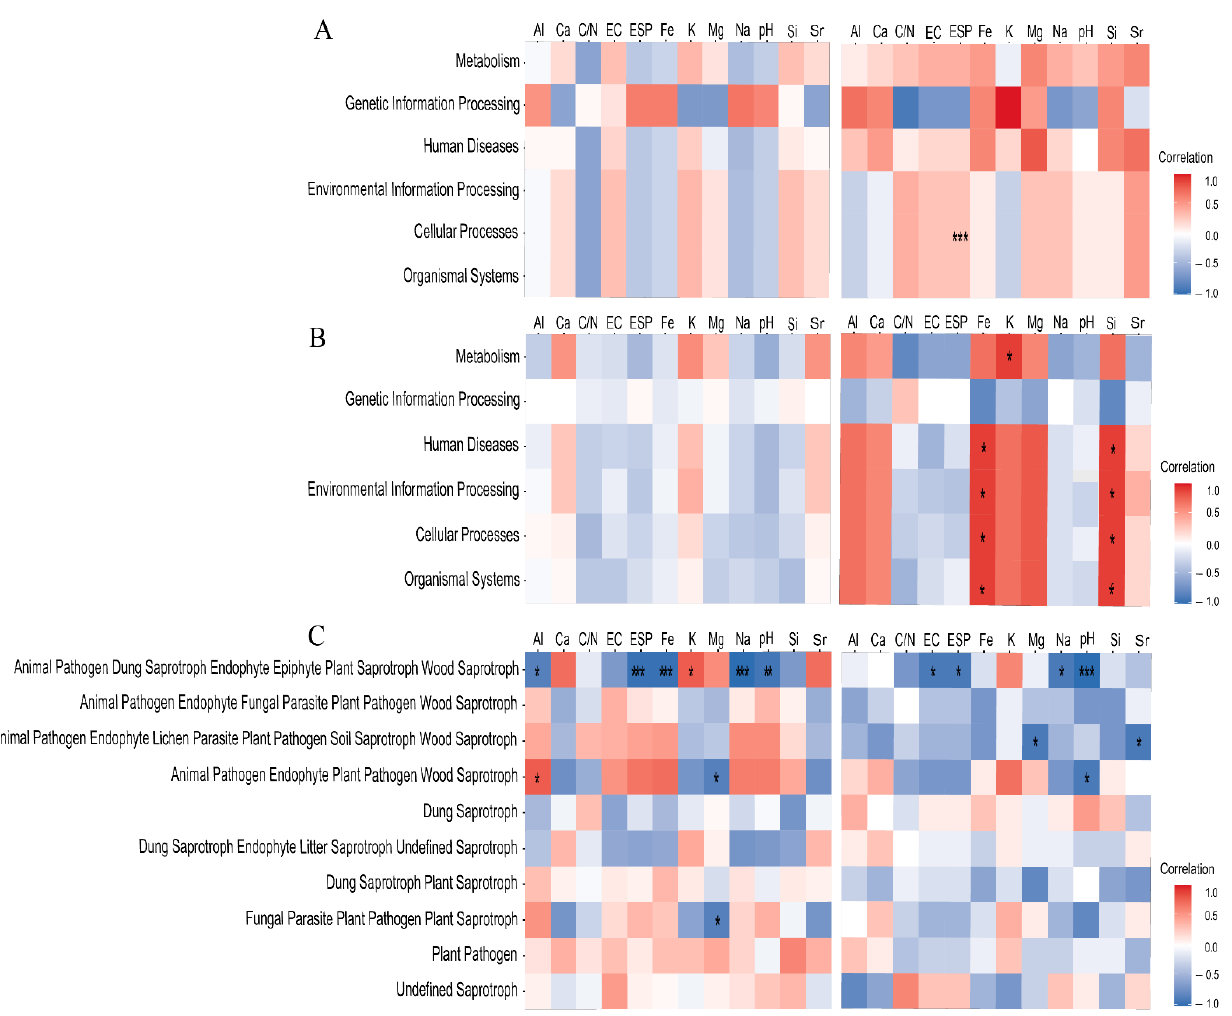
Figure 7. The correlation with saline (left) and sodic (right) soil environmental factors and relative abundance of archaeal ( A ), bacterial ( B ), and fungal ( C ) functional prediction. * p < 0. 05; ** p < 0.01; *** p < 0.01.